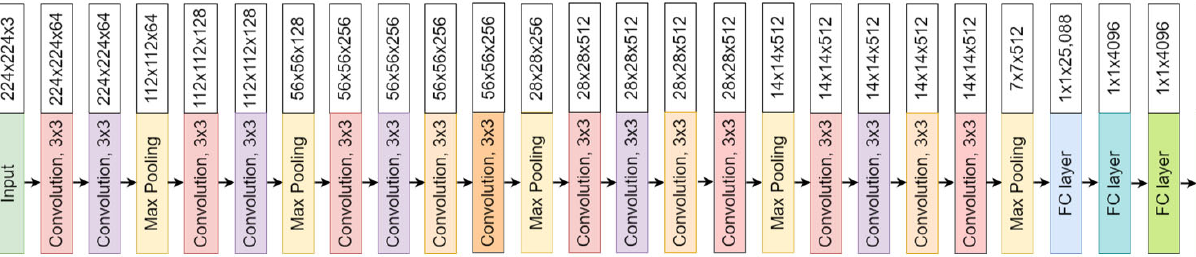
Figure 5. VGG16 architecture. Figure 6. VGG19 architecture.